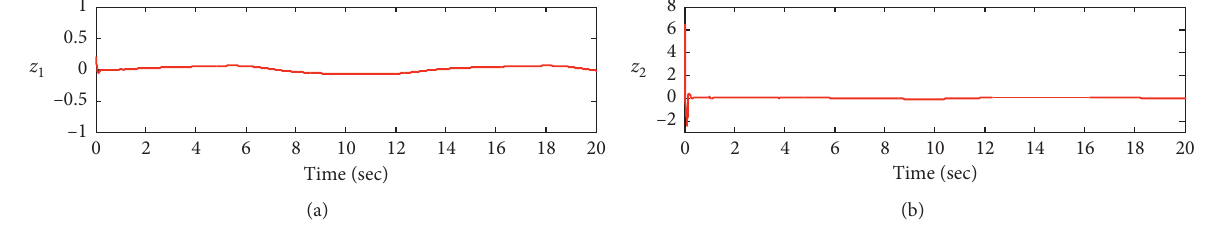
Figure 4: Profiles of the tracking errors z